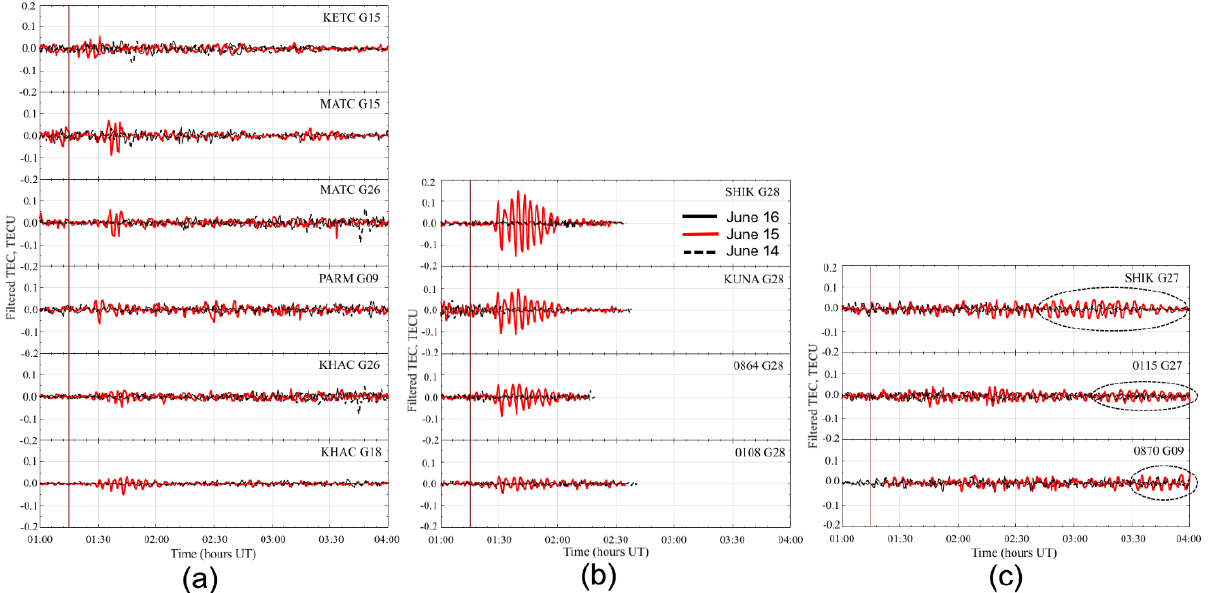
Figure 7. Examples of covolcanic ionospheric disturbances initiated by the volcanic explosion occurred at 01:15 UT on 15 June 2009. Filtered vertical TEC series are shown for three consecutive days (14 – 16 June). ( a ) TEC series exhibiting CVIDs to the north-northeast (MATC − G15, PARM − G09), south (KETC − G15) and northwest (MATC − G26, KHAC − G26, KHAC − G18) from the volcano. ( b ) TEC series for the satellite G28. ( c ) The examples of CVIDs observed after 02:30 − 03:30 UT at ~600 – 700 km to the southwest from Sarychev Peak. All other notations are identical to the appropriate ones adopted in Figure 3.